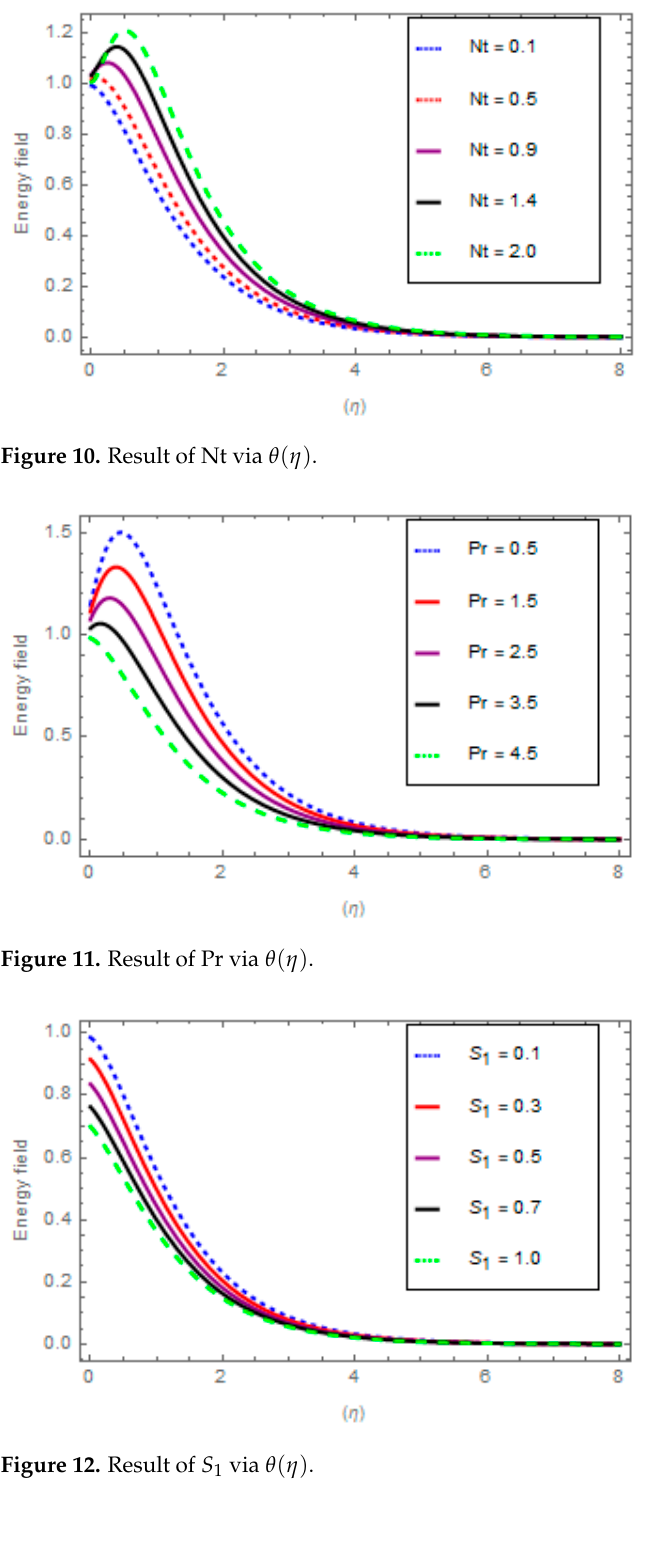
Figure 12. Result of 1 S via